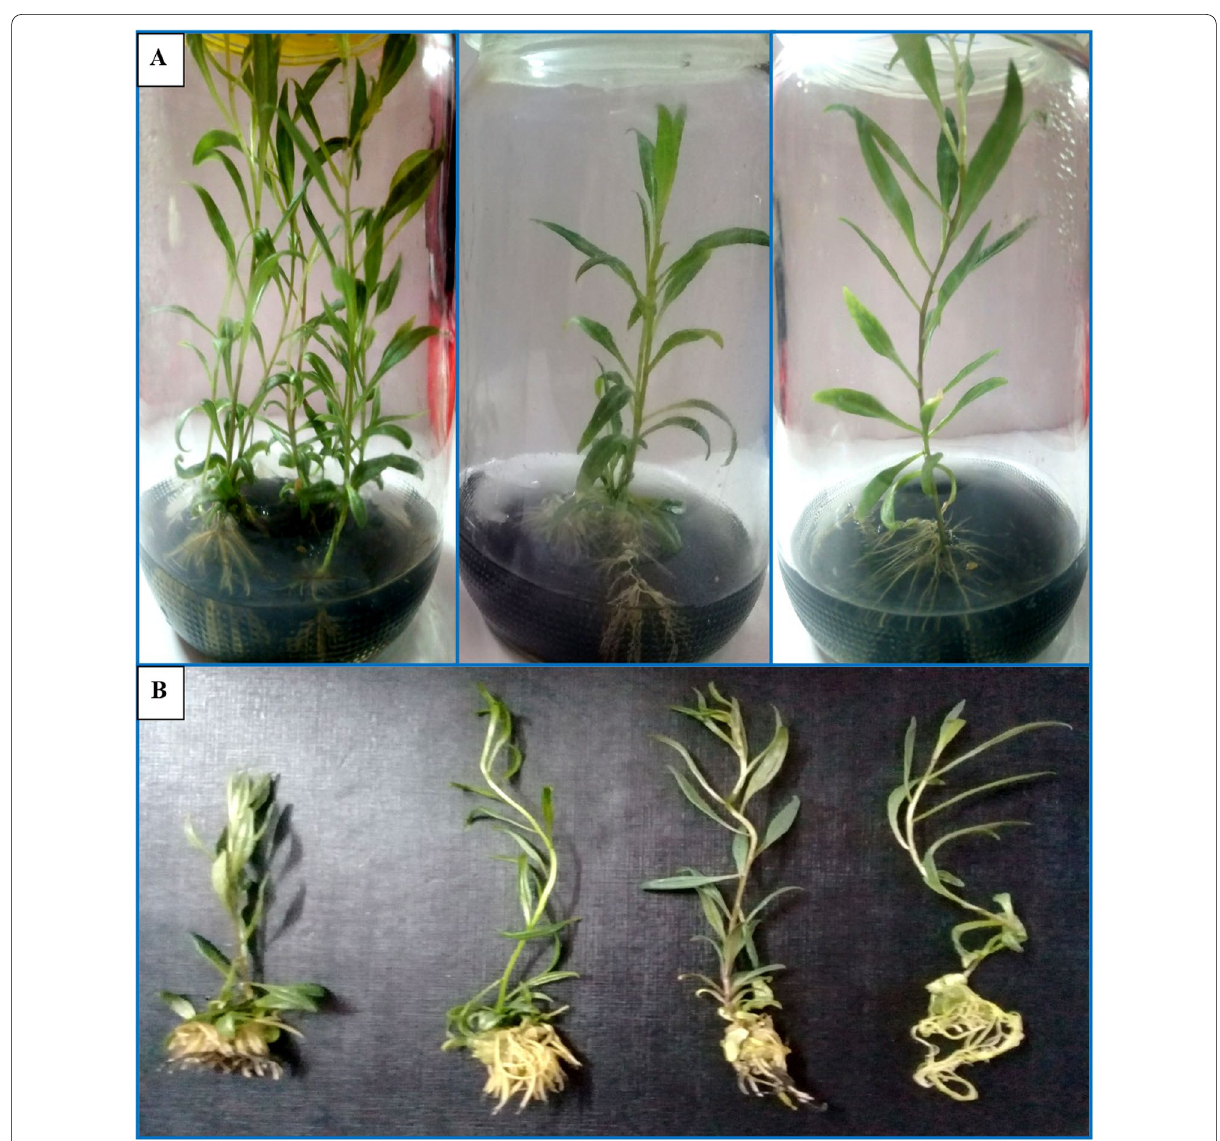
Fig. 6 Rooting of L. barbarum adventitious shoots. a : MS medium containing 304.86 µM IBA. b : MS medium containing 304.86 µM